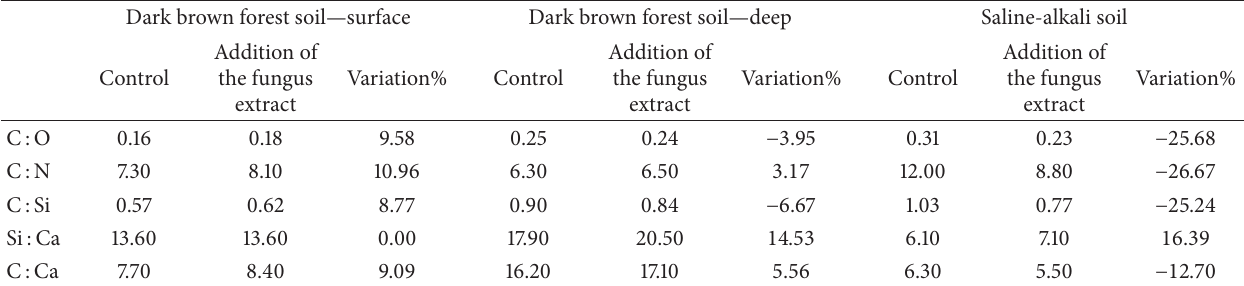
Table 1: Results from X-ray photoelectron spectroscopy of the variation in element ratios with and without the addition of the fungus extract. Dark brown forest soil—surface Dark brown forest soil—deep Saline-alkali